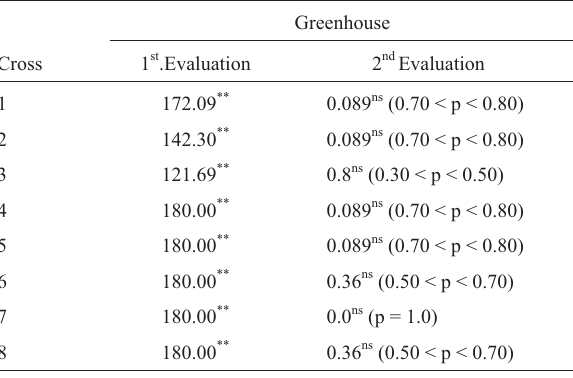
Table II - Number of plants classified as resistant and susceptible within each studied cross.